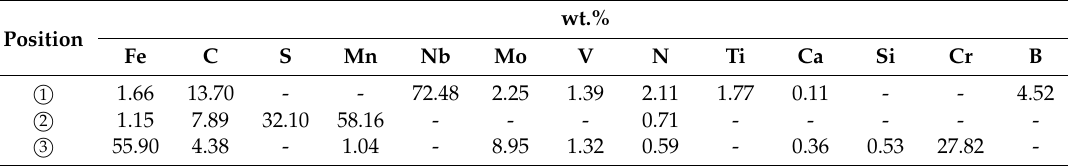
Figure 12. Composition distribution of the grain boundary region at the solidification end of TS1. Table 2. The result of point analyses by electron microprobe.